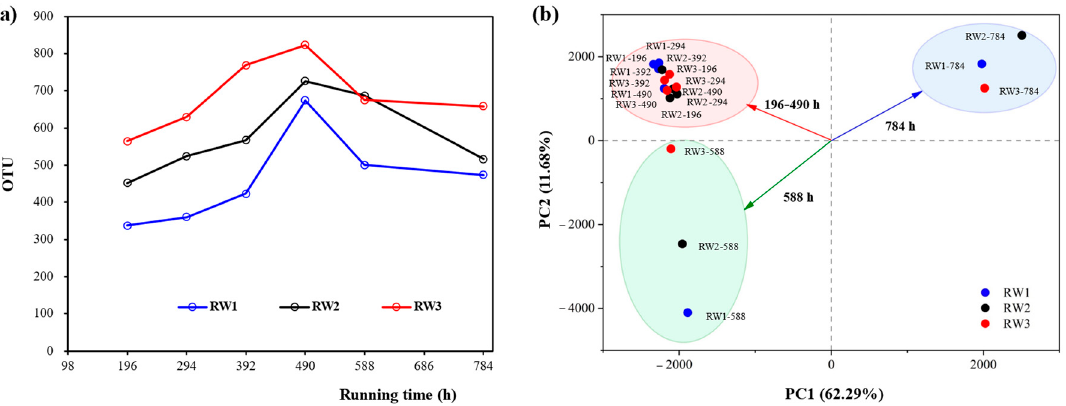
Figure 3. Variation patterns of OTUs in biofilms and principal component analysis of the microbial community. ( a ) Variation of OTUs in organisms; ( b ) Principal component analysis of microbial community in biofilm.